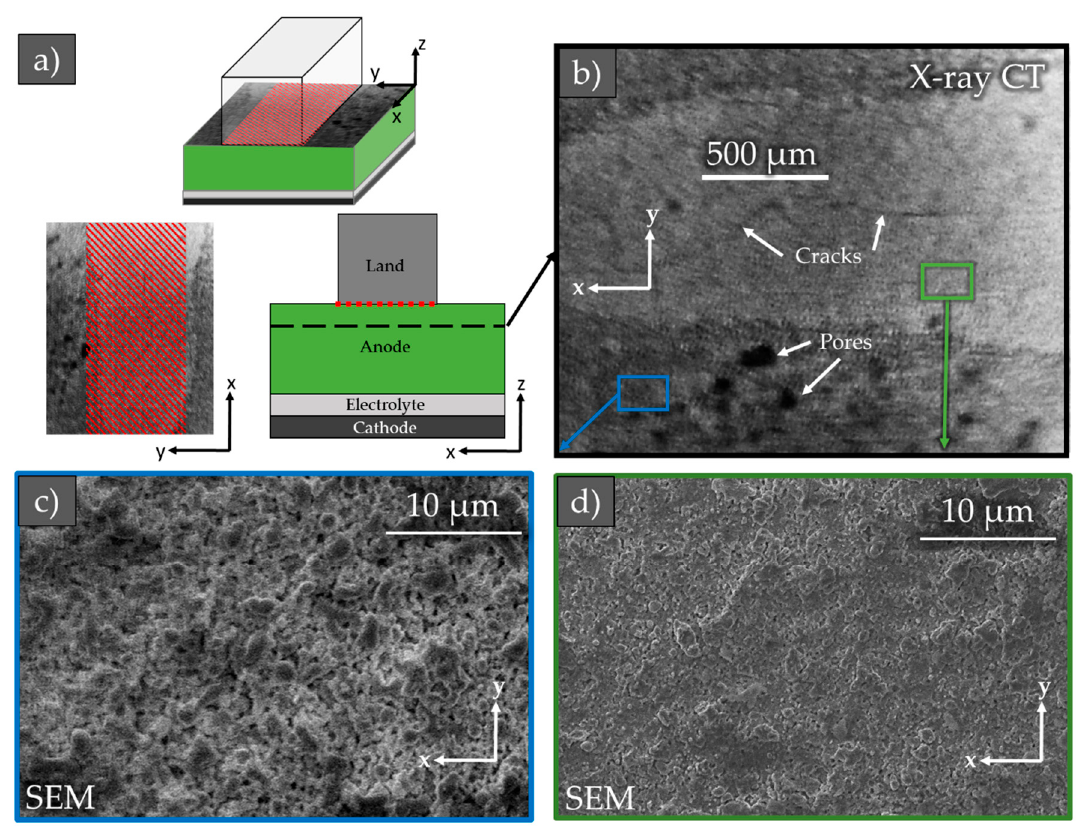
Figure 4. Microstructural information obtained from an SOFC cell: ( a ) geometric reference for the X-ray and electron imaging; ( b ) a sub-surface ortho-slice image taken from an X-ray CT tomogram; and SEM images of ( c ) the Ni-dominated channel and ( d ) NiO-dominated land. Raw SEM images can be found within the Supplementary Material (Figures S5–S7).